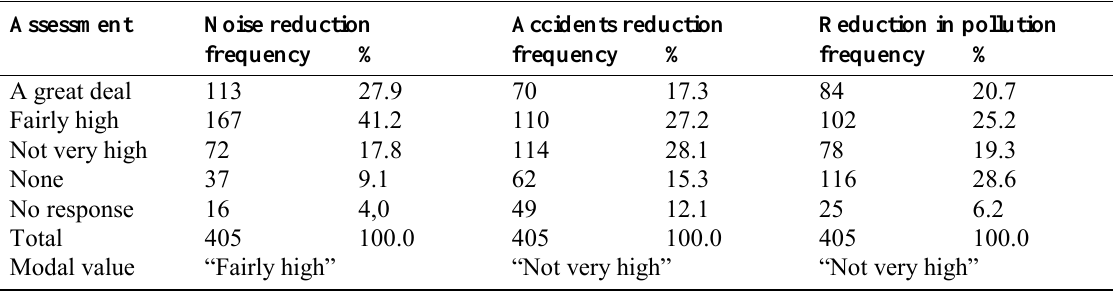
Table 2. Assessment of potential advantages of the by-pass